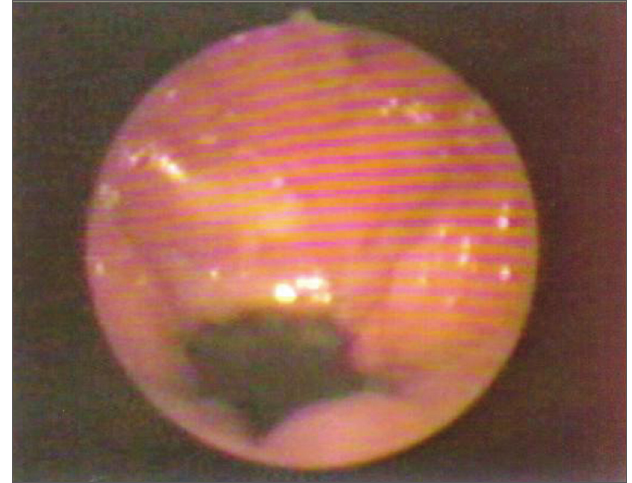
Figura 3. Paciente 2: fechamento do EVF em registro modal